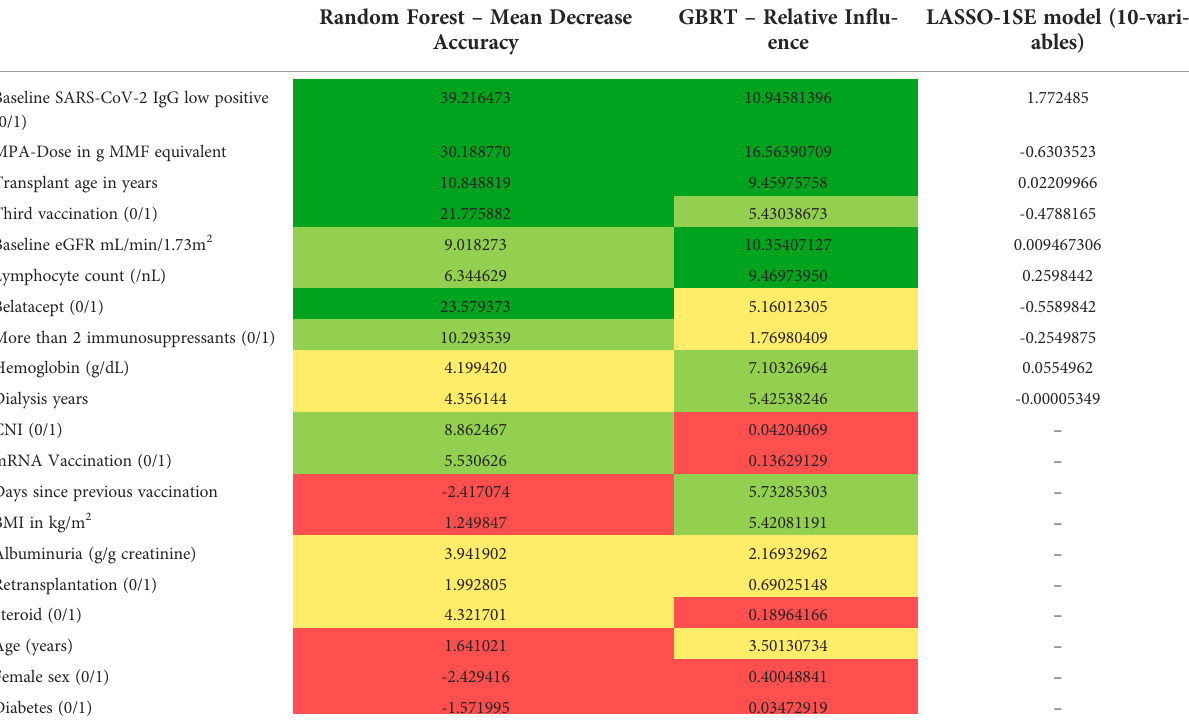
TABLE 8 Comparison of feature importance of random forest (RF), gradient boosted regression trees (GBRT), and variable selection in the LASSO- 1SE model. Random Forest – Mean